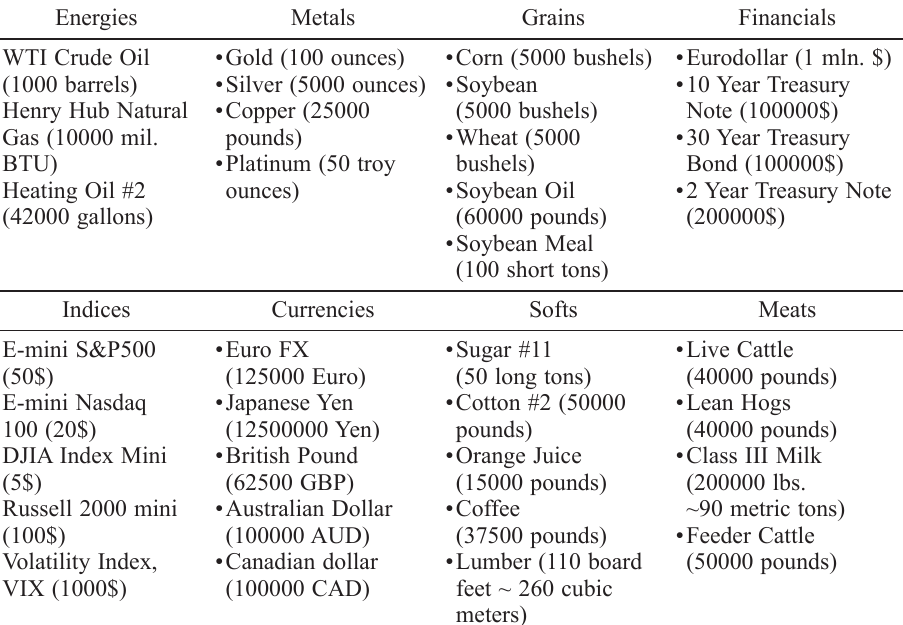
Table 1. The most active contracts in the sector Energies Metals Grains Financials